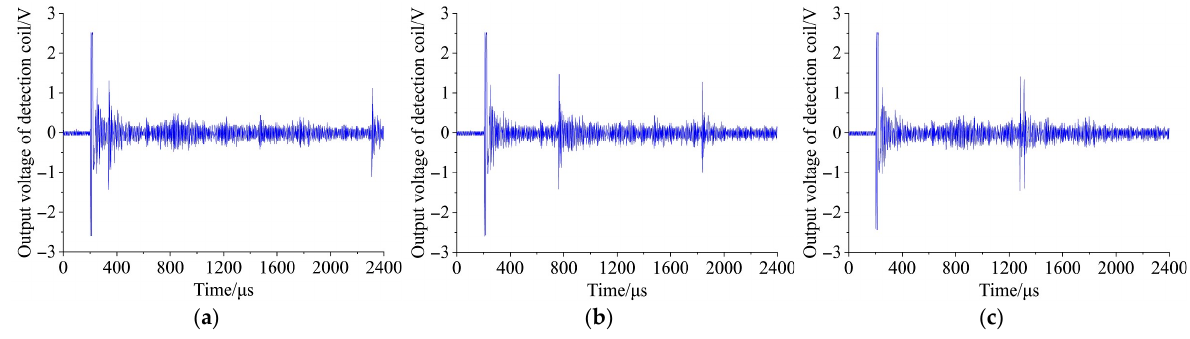
Figure 15. The waveform acquired by the oscilloscope when the magnetic field coil is conducting at the ( a ) head, ( b ) middle, and ( c ) end positions of the waveguide wire. The signal waves with peaks above 1 V in the fi gures show the pulse wave, the initial